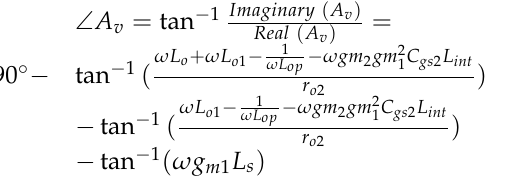
Figure 8. Gain, stability, and Input P1dB versus the main transistor channel width.